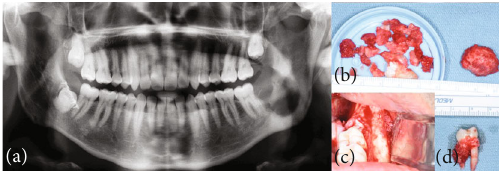
Figure 5: (a) Case #1 panoramic radiograph one month post excisional biopsy showing the lesion and #17 completely removed with bony sclerosis still visible. (b) Case #1 surgical specimen. (c) Case #1 intraoperative clinical photo. (d) Case #2 surgical specimen showing the lesion in association with the distal root of